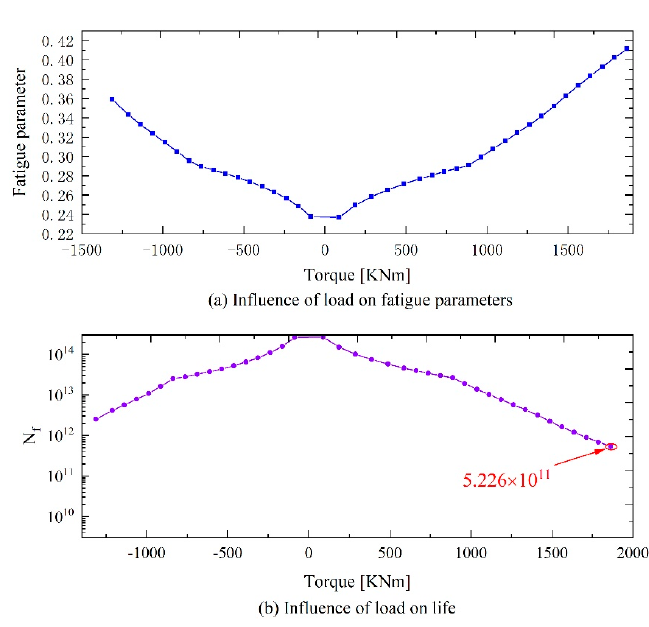
Figure 13. Influence of load on fatigue parameters and life, ( a ) influence of load on fatigue parameters, ( b ) influence of load on life.